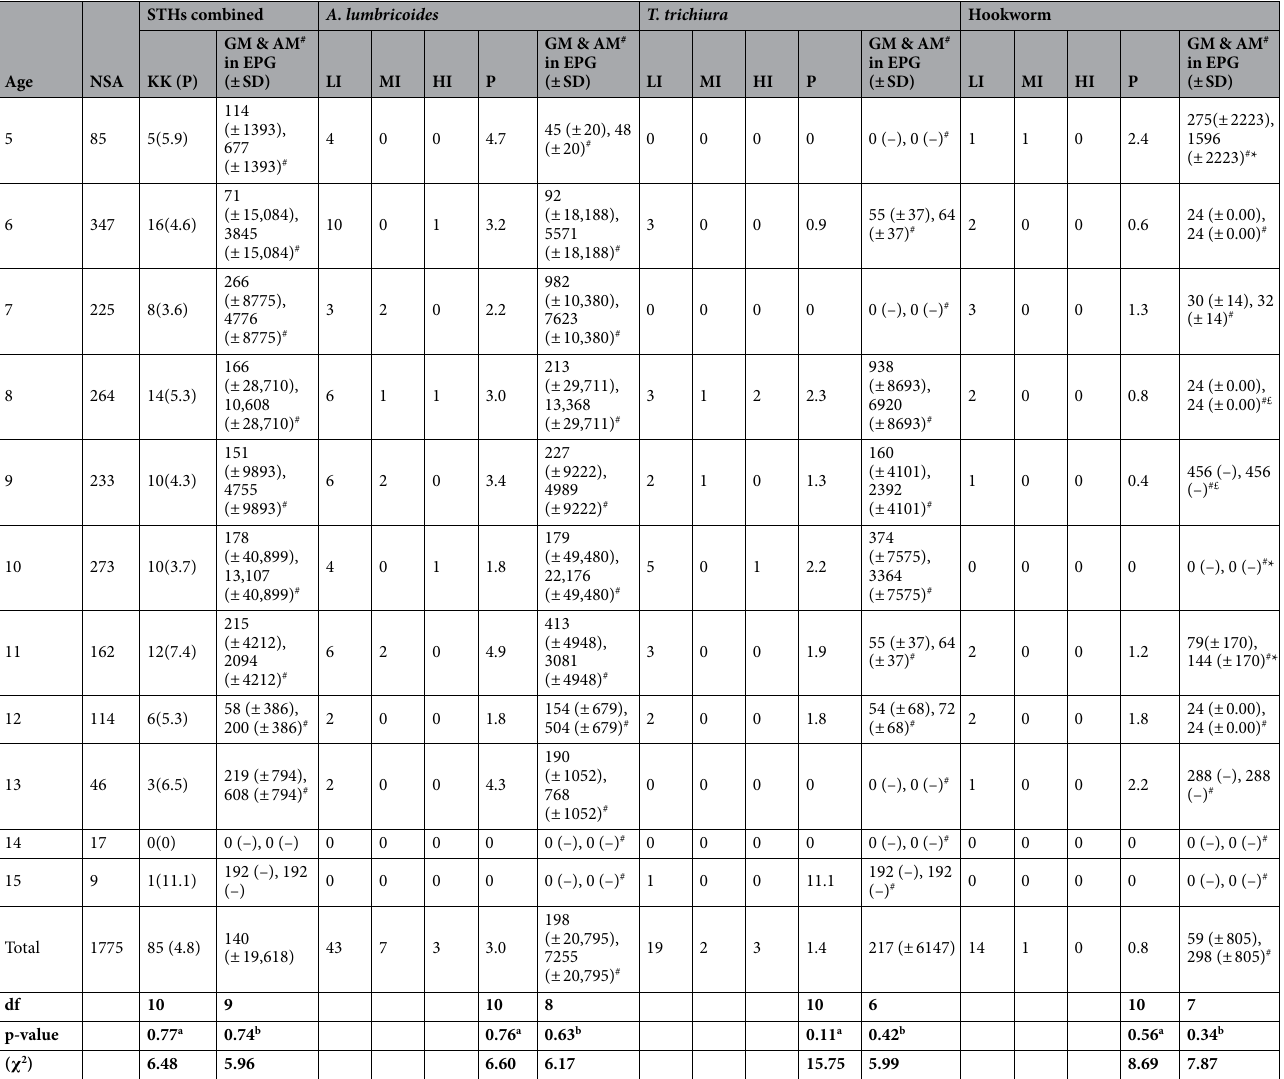
Table 2. Prevalence and infection intensities of soil-transmitted helminth species according to age. STHs soil transmitted helminths; A. lumbricoides , Ascaris lumbricoides ; T. trichiura , Trichuris trichuria ; NSA number of stool samples analysed; KK overall number of children positive for the kato katz; GM geometric mean egg count; AM # arithmetic mean egg count; SD standard deviation; LI number of children having light infection; MI number of children having moderate infection; HI number of children having heavy infection; EPG egg per gram of stool, P prevalence; df degree of freedom. Significant values are in [bold]. *One co-infection. £